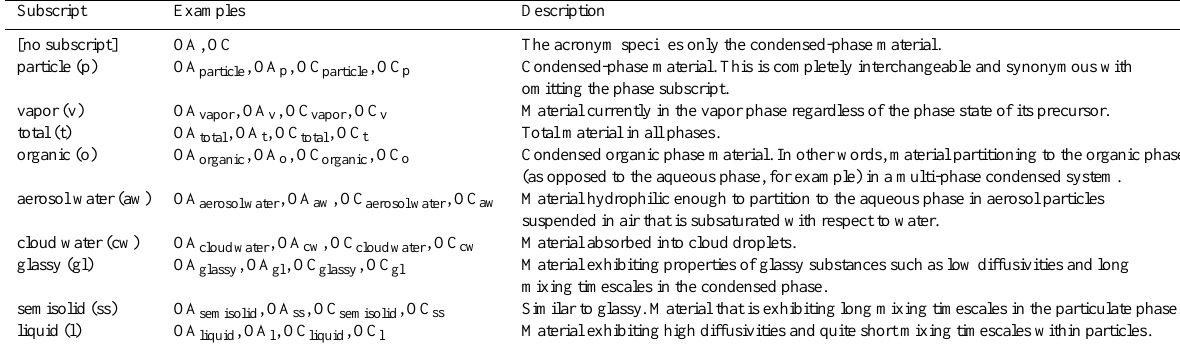
Table 2. Examples of phase subscripts for OA